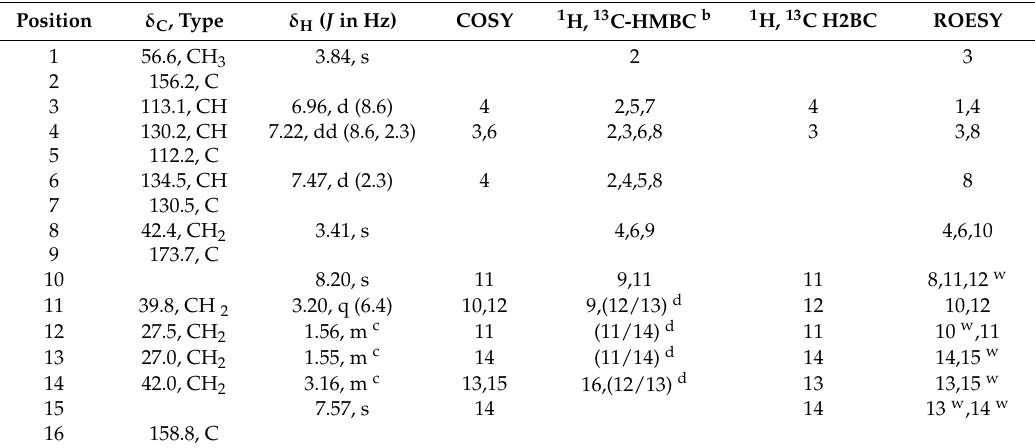
Figure 2. Key HMBC, ME-HSQC, H2BC, COSY, and ROESY correlations of Securidine A ( 1 ). Figure 2 Key HMBC, ME-HSQC, H2BC, COSY, and ROESY correlations of Securidine A ( 1 ). Table 1. NMR spectroscopic data a (600 MHz, methanol- d 3 Table 1. NMR spectroscopic data a (600 MHz, methanol- d 3 ).